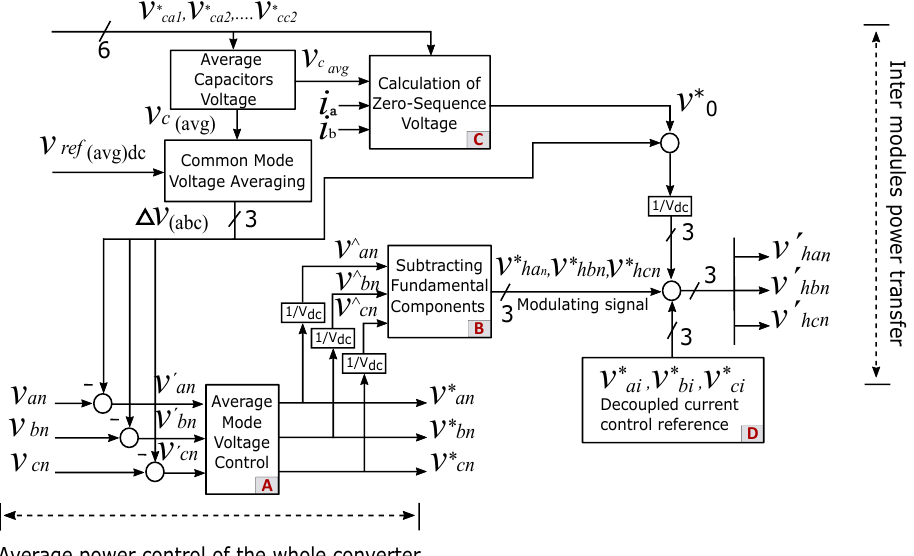
Figure 7. General block diagram of the AHMMC’s